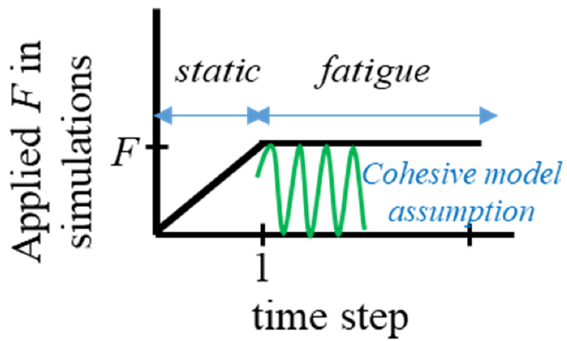
Figure 3. The variation of the tensile load applied to the step-lap joints.